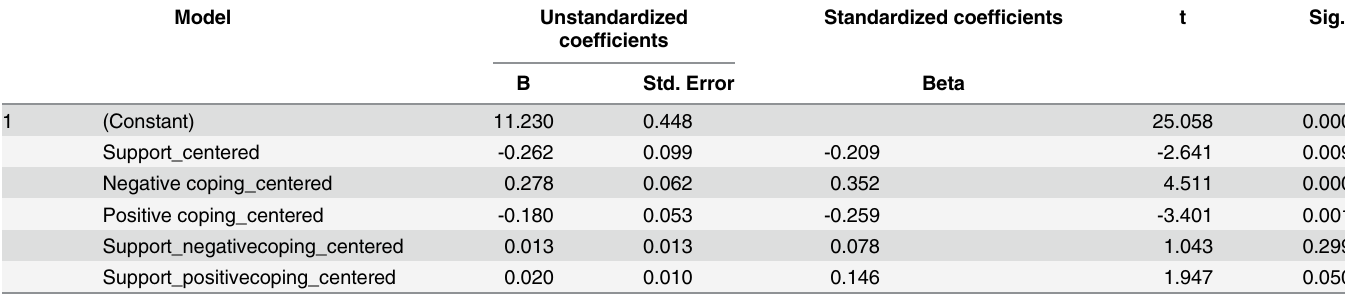
Table 6. Regression analysis of social support (centered), negative coping styles (centered), and positive coping styles (centered) in relation to EPDS scores. Model